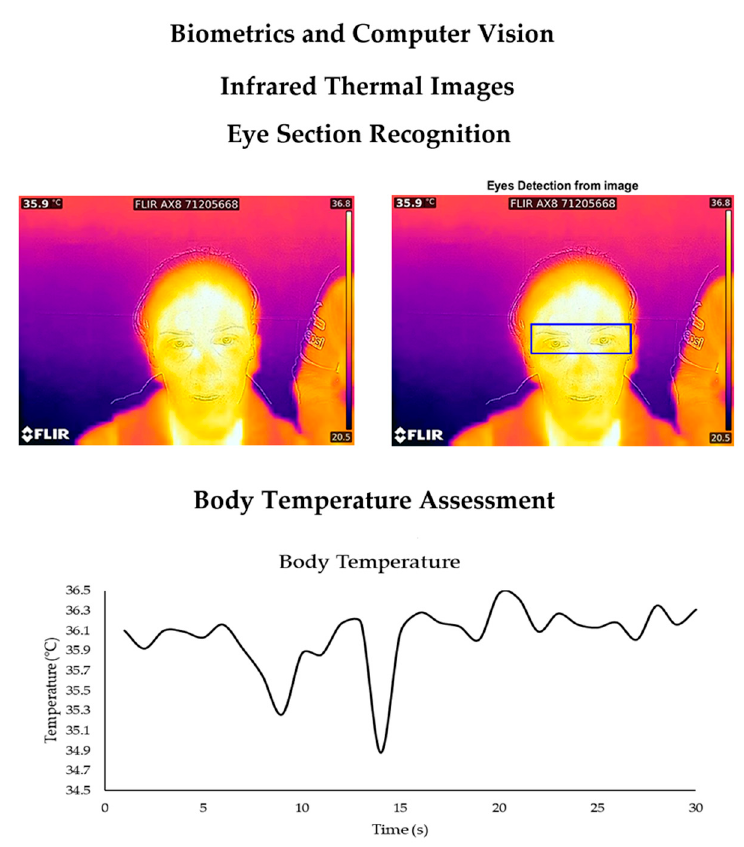
Figure 4. Diagram showing the technique used to measure body temperature from consumers during the sensory sessions using an infrared thermal camera and computer vision algorithms capable of recognizing the eye section .